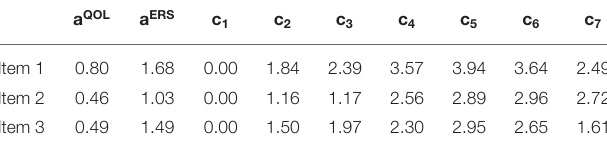
TABLE 5 | Parameters for three items measuring QOL and ERS.